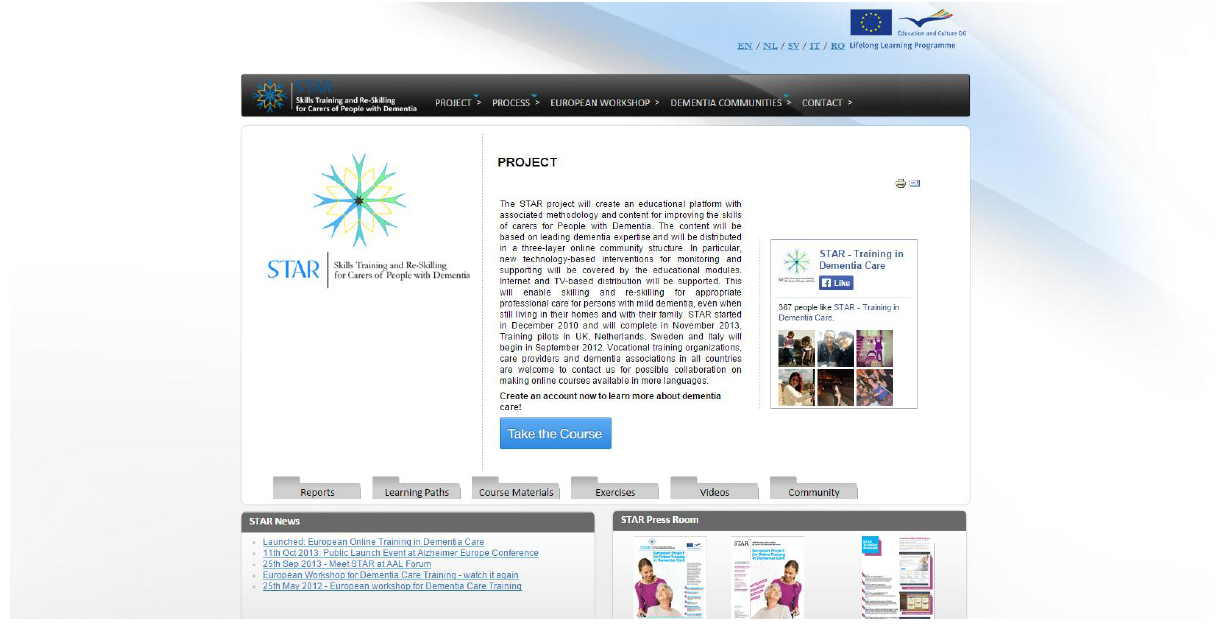
Figure 1. The main project